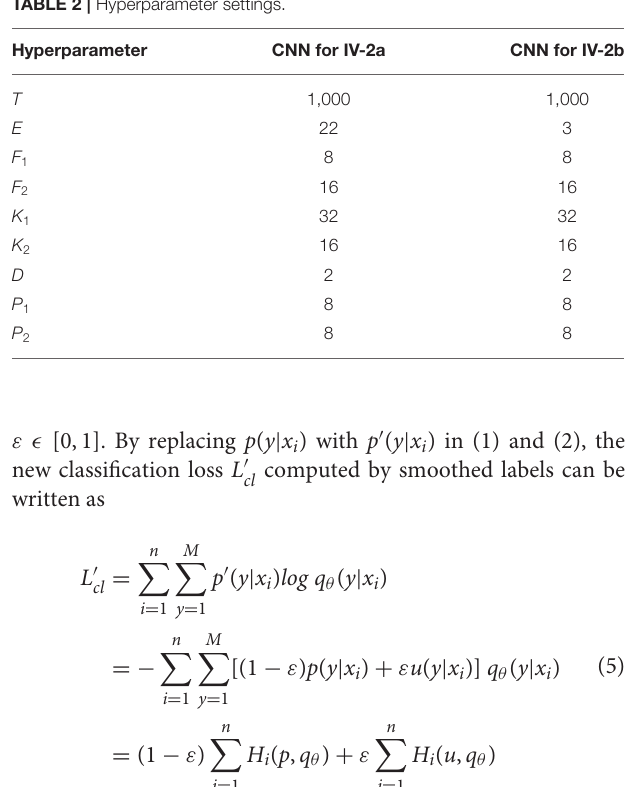
TABLE 1 | Architecture setting. TABLE 2 | Hyperparameter